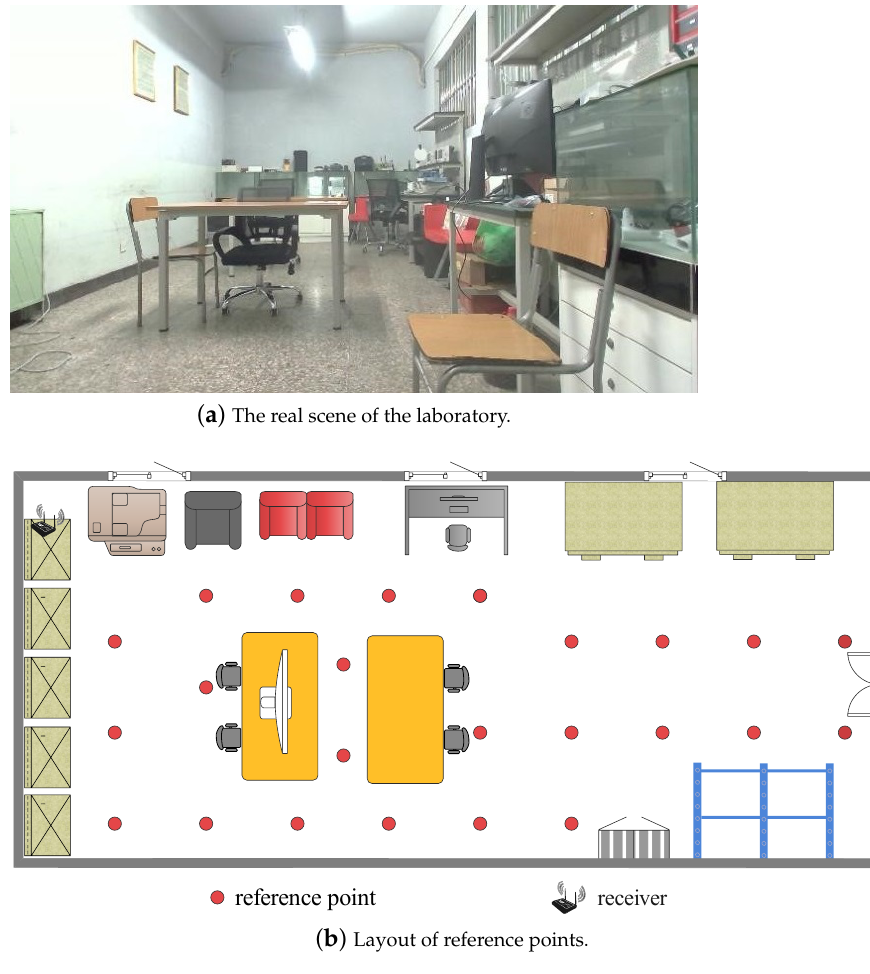
Figure 8. The diagram of the laboratory environment.